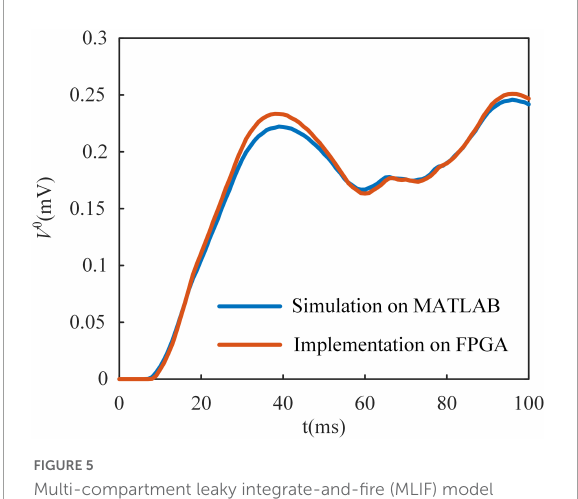
FIGURE5 Multi-compartment leaky integrate-and-fire (MLIF) model implemented on field-programmable gate array (FPGA) is compared with it simulated in MATLAB with the same random input. There is only a small difference between the MLIF model in simulation and its implementation on the FPGA.